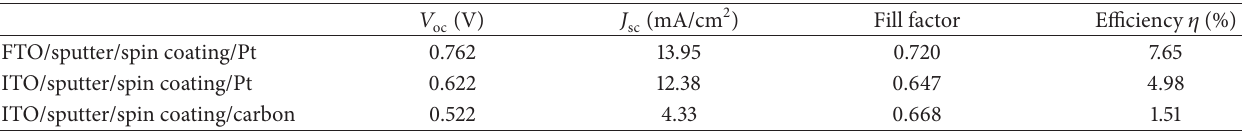
layer, with carbon and Pt counter electrodes, using FTO and 2